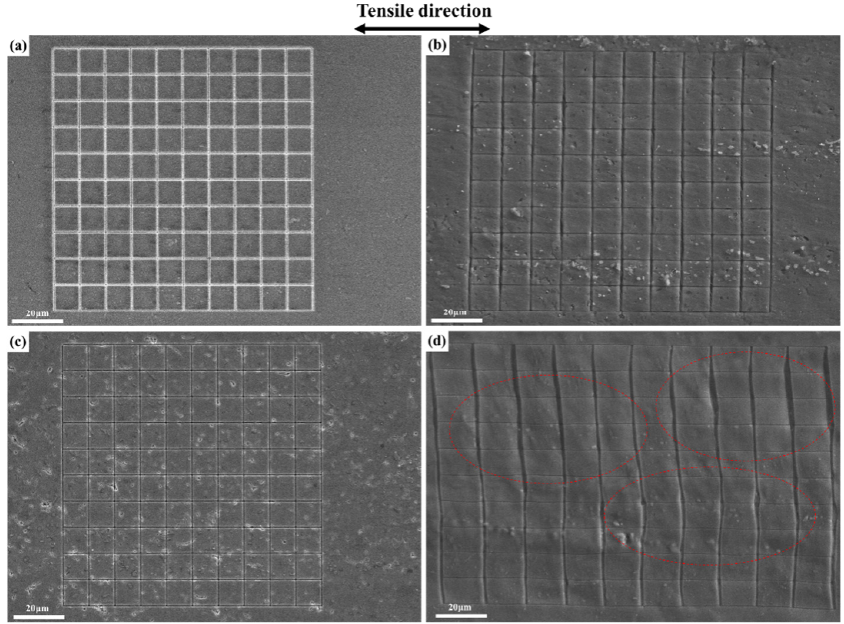
Figure 11. OM observations on the surface of the Cl sample of TDSP tensioned to a strain of 0.12 at different temperatures: ( a ) 25 °C; ( b ) − 196 °C.